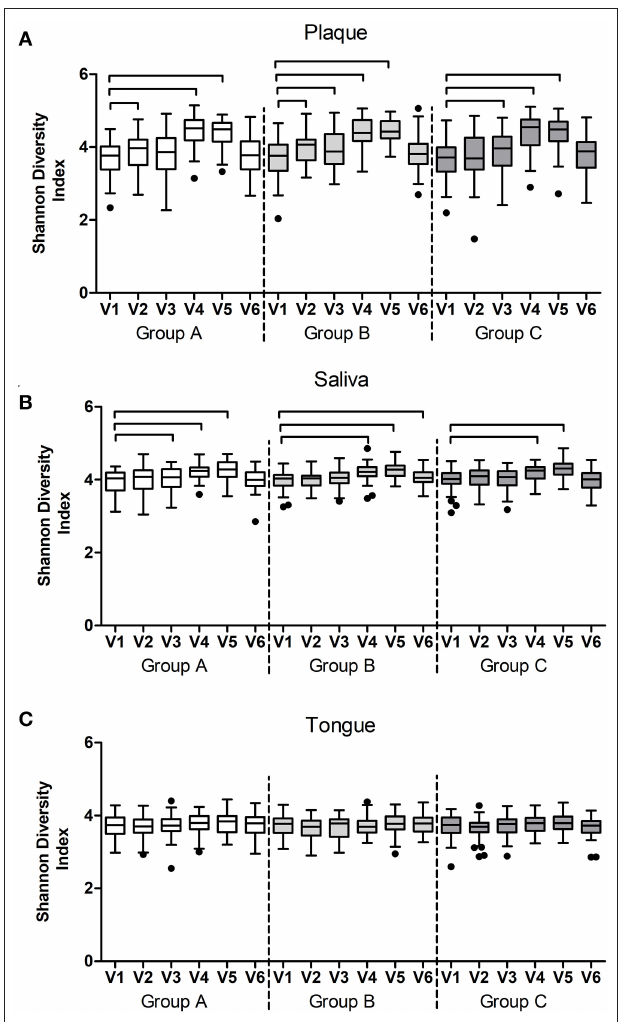
FIGURE 10 | Shannon Diversity Index per study group and visit of (A) plaque, (B) salivary, and (C) tongue microbiome samples. The connectors connect the visits that differed significantly ( P < 0.05, Wilcoxon Signed Ranks test) from the baseline visit.